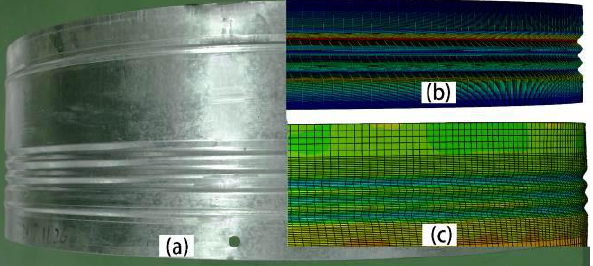
Figure 4. Results of experimental and numerical simulation. ( a ) Experimental result; ( b ) 2D numerical simulation; ( c ) 3D numerical simulation.